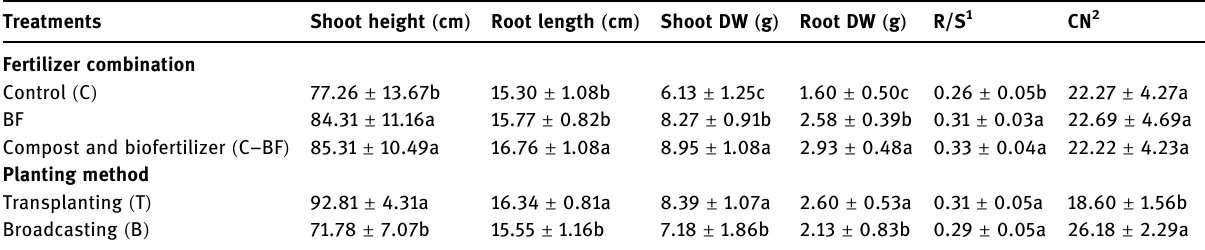
Planting method